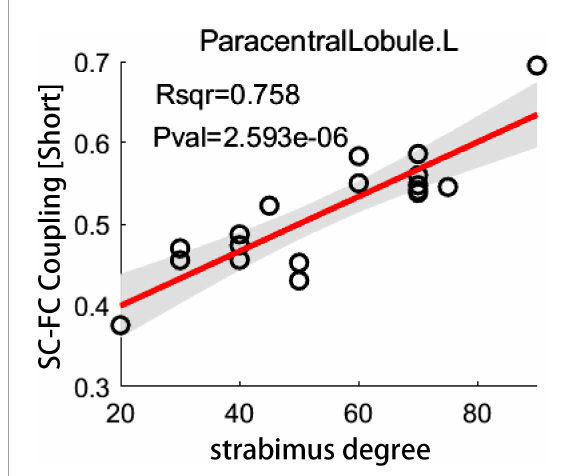
FIGURE5 The correlation between coupling score and strabismus degree. Scatter plot depicts a significantly positive correlation between coupling score for short connections in left paracentral lobule and strabismus degree in patients with infantile esotropia ( P < 0.05, corrected by FDR). SC, structural connectivity; FC, functional connectivity; L, left.